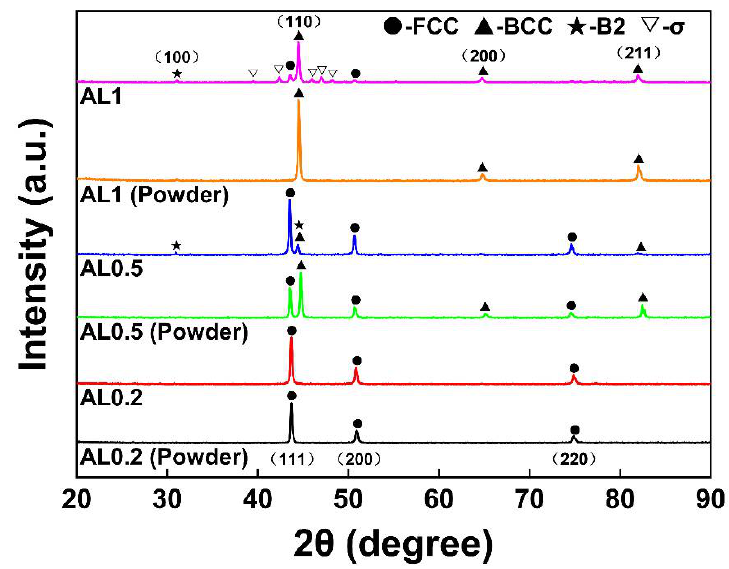
Figure 1. XRD patterns of AlxCoCrFeNi (x = 0.2, 0.5 and 1) HEAs powders and alloys.